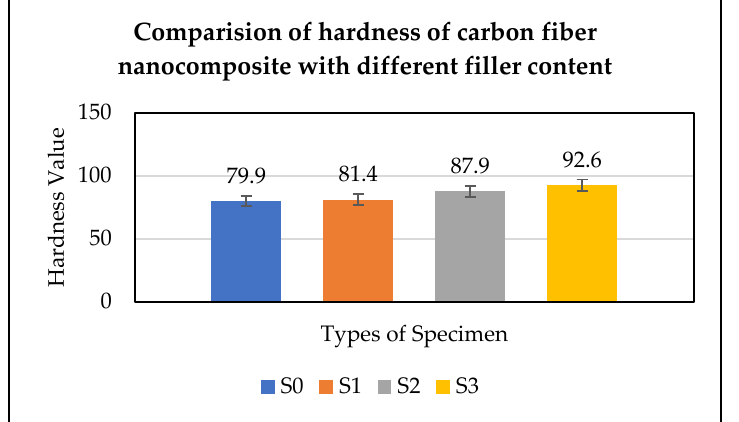
Figure 8. Shore D Hardness. Figure 8. Shore D